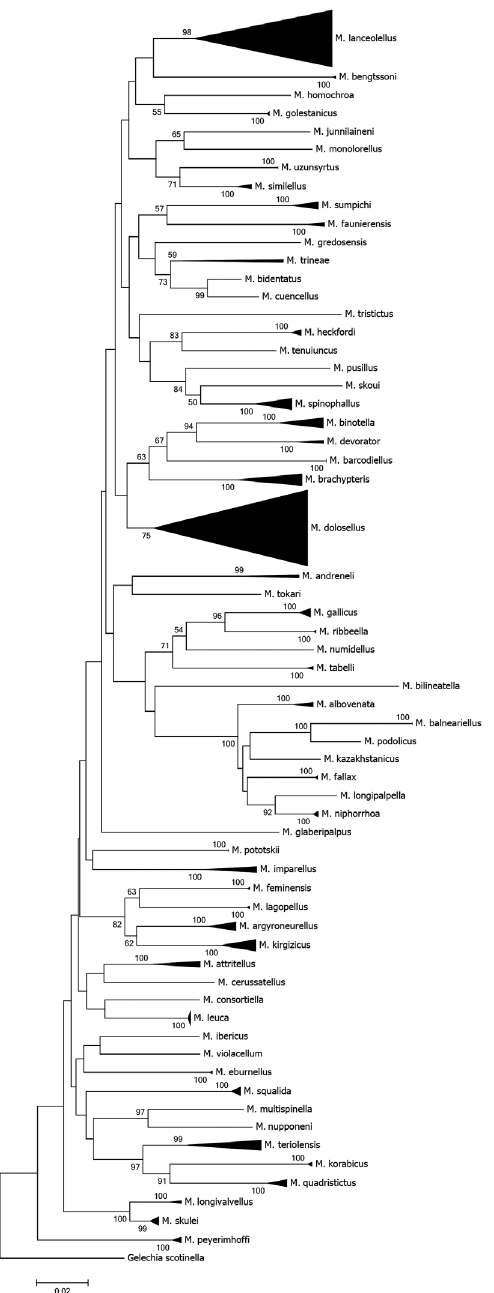
Figure 6. Maximum likelihood tree (built with MEGA7) of cytochrome c oxidase subunit I (COI) barcode fragments. Values on branches represent bootstrap values of ≥ 50 % inferred from 500 replicates, scale bar rep- resents substitutions per site. Note: the scale bar only applies to internal branches between species. The width of the triangles represents the sample size, and the depth the relative genetic variation within the cluster (2× scale bar). Source: DNA Barcode data from BOLD (Barcode of Life Database, cf. Ratnasingham and Hebert